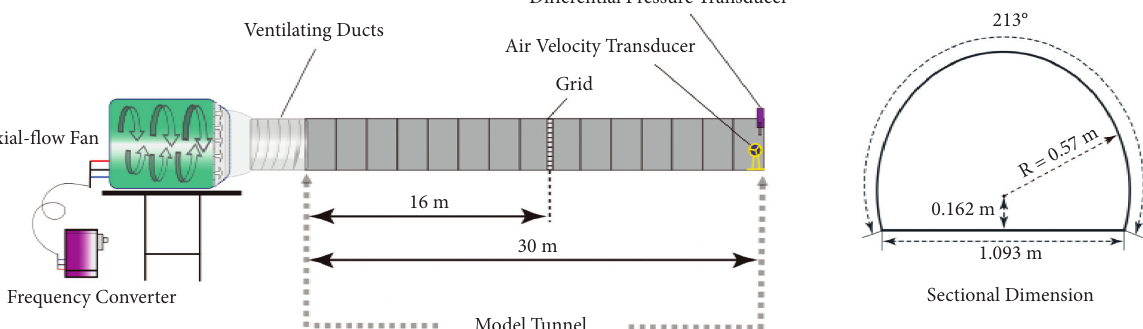
Figure 5: Tunnel simulation system.